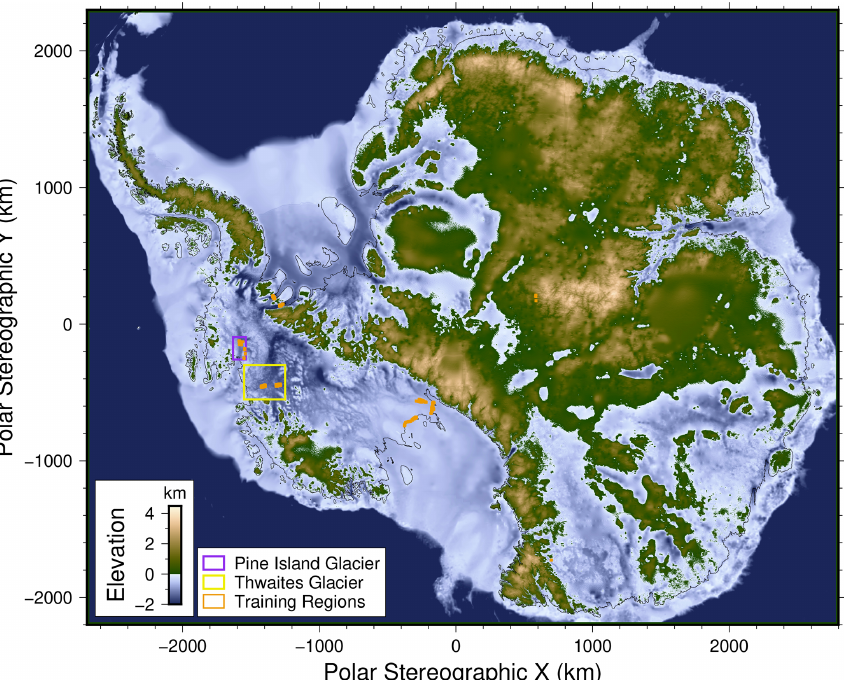
Figure 2. DeepBedMap_DEM over the entire Antarctic continent. Plotted on an Antarctic stereographic projection (EPSG:3031) with eleva- tion referenced to the WGS84 datum. Grounding line is plotted as thin black line. Purple box shows Pine Island Glacier extent used in Fig. 3. Yellow box shows Thwaites Glacier extent used in Fig. 5. Orange areas show locations of training tiles (see Table